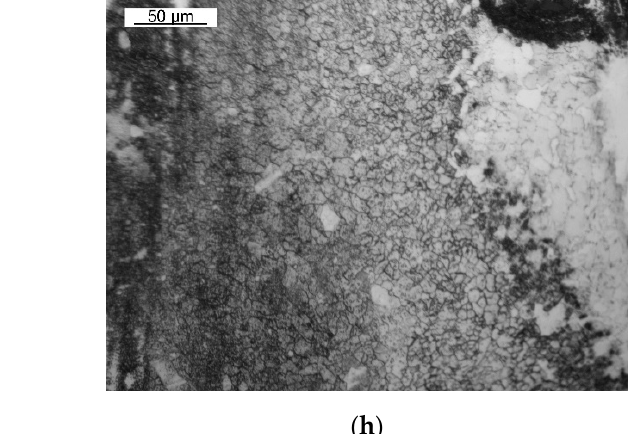
( g ) ( h ) Figure 14. The microstructure of the investigated samples at the area of erosion wear: ( a , d , h ) DC03 30-second sample; ( b , g ) DC03 60-second sample; ( c , e ) DC05 30-second sample; ( f ) DC05 60-second sample.